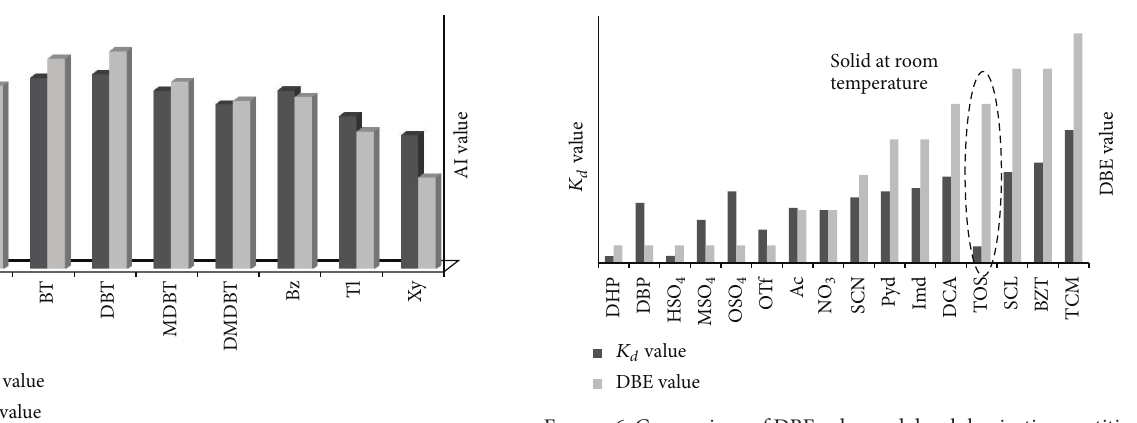
Figure 4: Comparison of extractability ( 𝐾 𝑑 value) organosulphur and aromatic hydrocarbon compounds collected from the literature [8, 10–12] and AI value.